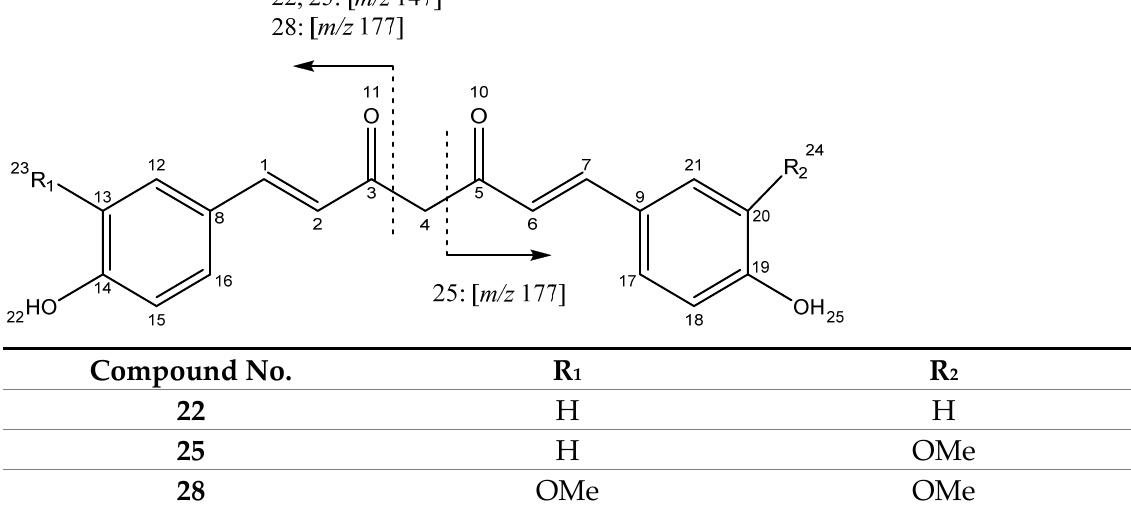
Figure 2. Structure and main fragments for compounds 22 , 25 and 28 .